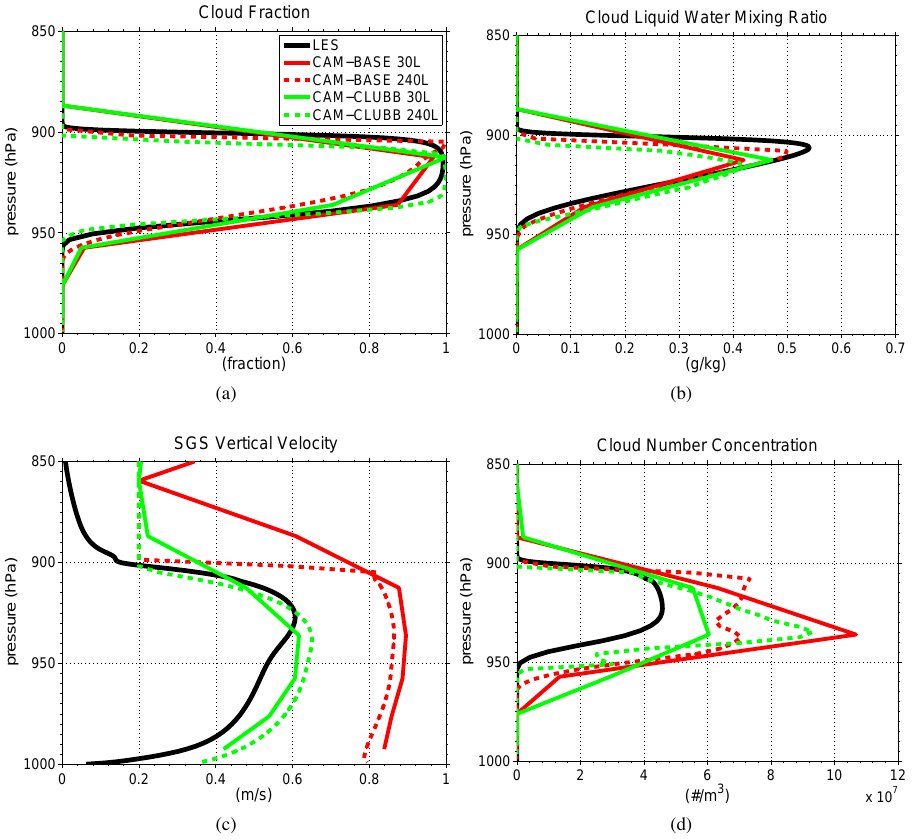
Fig. 12: Same as Fig. 2 except SCAM profiles represent DYCOMS2-RF02 simulations averaged over hours 4–6, with fixed 30 and 240 vertical levels and ∆ t =300s .